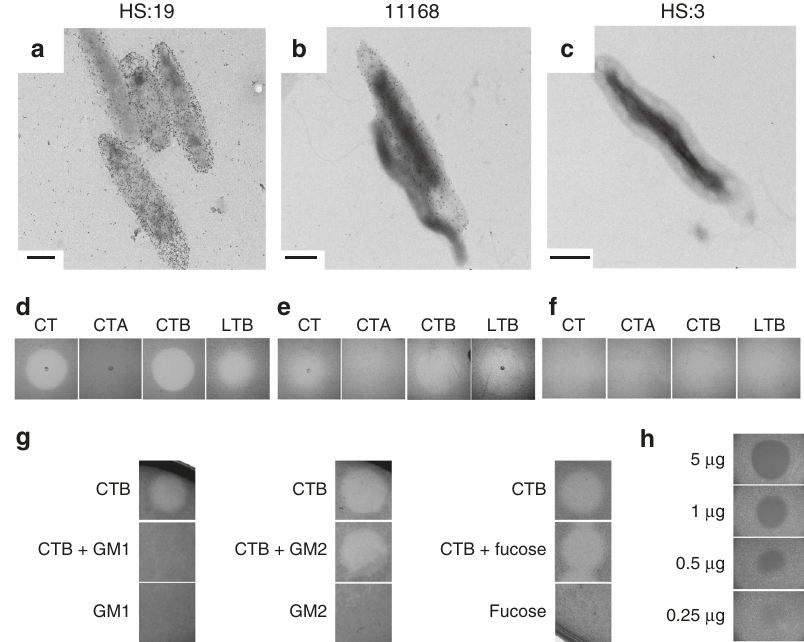
Fig. 2 Cholera toxin B subunit (CTB) and heat-labile enterotoxin B subunit (LTB) bind and clear GM1 ganglioside-mimicking C. jejuni strains. a – f Transmission electron micrographs depicting different C. jejuni strains bound by immunogold-labeled CTB ( a – c , scale bars are 0.5 μ m), accompanied by images of agar plates showing C. jejuni following exposure to 2 μ L of either CT, CTB, CTA, or LTB (each at 1 mg mL -1 ) for 24 h while growing in soft agar ( d – f ). a , d C. jejuni HS:19. b , e C. jejuni 11168. C, F) C. jejuni HS:3. g Competitive clearance assay where CTB was mixed 1:1 with indicated glycans prior to spotting onto growing C. jejuni HS:19. h CTB spotted on C. jejuni HS:19 in various concentrations to determine the amount needed for